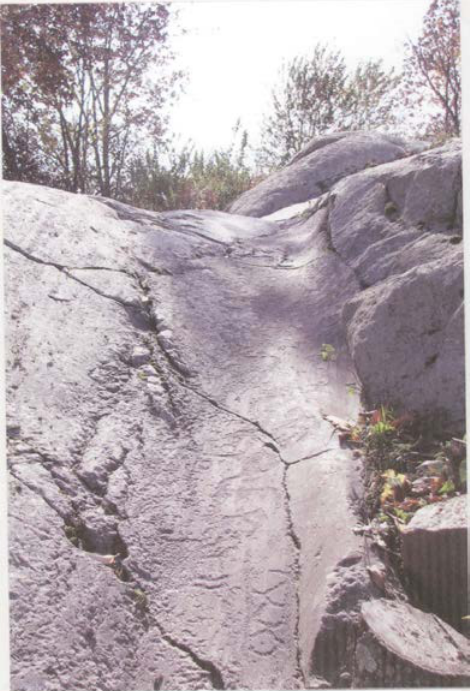
Figure 2. Decorated seam of Andulusite Schist between domes of Waterloo Quartzite at the Hensler Petroglyph Site. View from